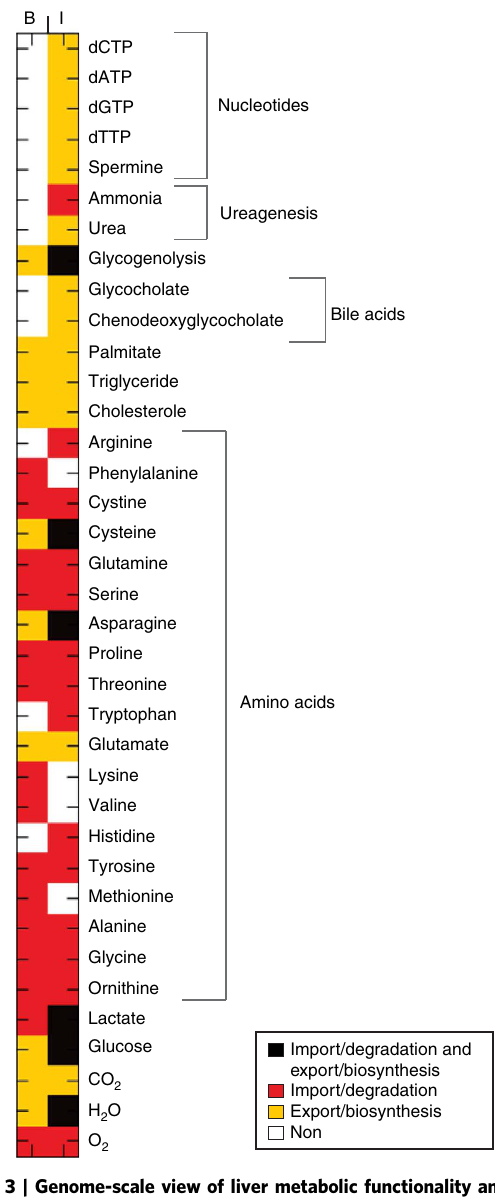
Figure 3 | Genome-scale view of liver metabolic functionality and splanchnic fluxes in the basal state (B) and in low-dose insulin infusion (I) obtained from flux-based GSMM analysis. Metabolites that can be exported/synthesized (imported/degraded) are coloured yellow (red). If both import and export are feasible (infeasible) then the corresponding square is coloured black (white). The first and second columns correspond to the basal state and low-dose insulin infusion simulations,